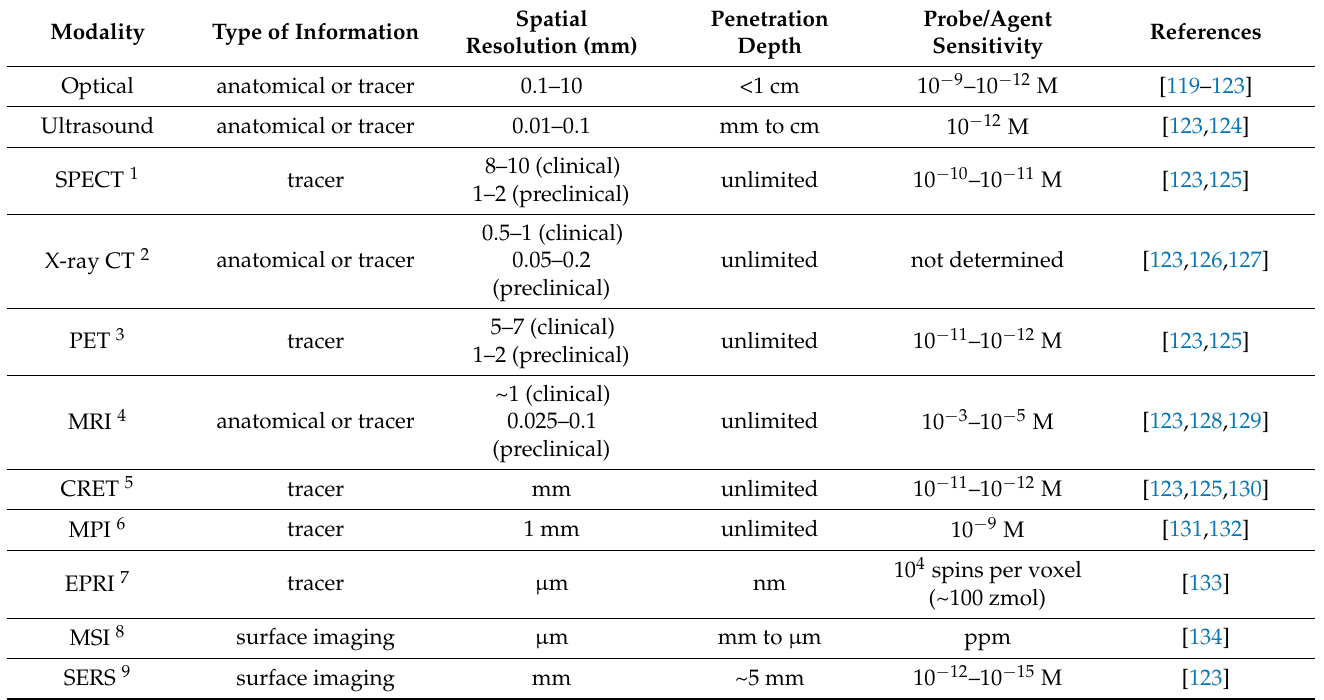
Table 2. Summary of imaging modalities and their properties frequently used for tumor